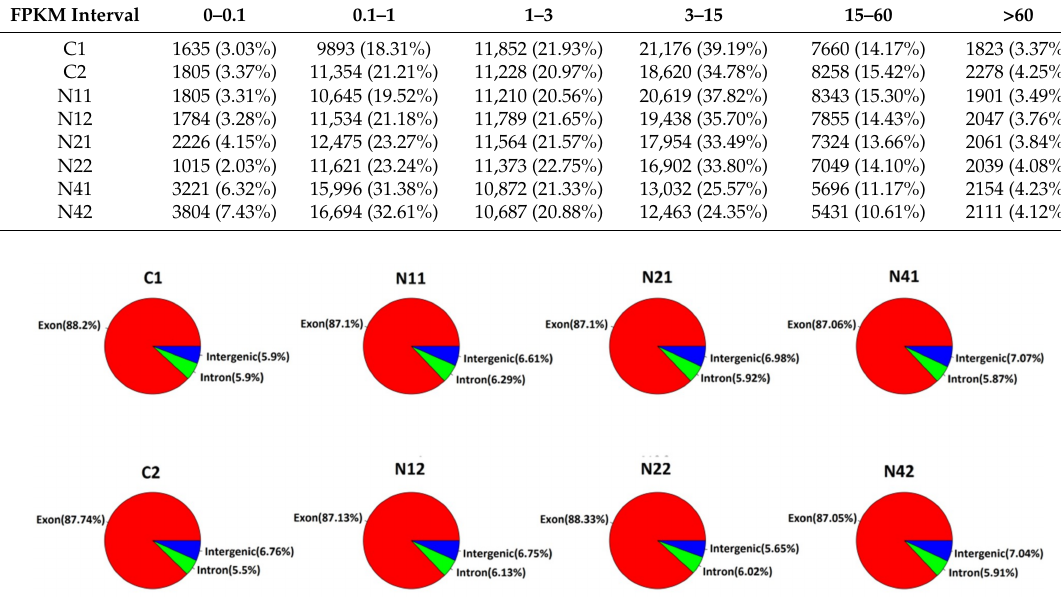
Figure 1. The comparison of clean reads with reference genome in different regions.